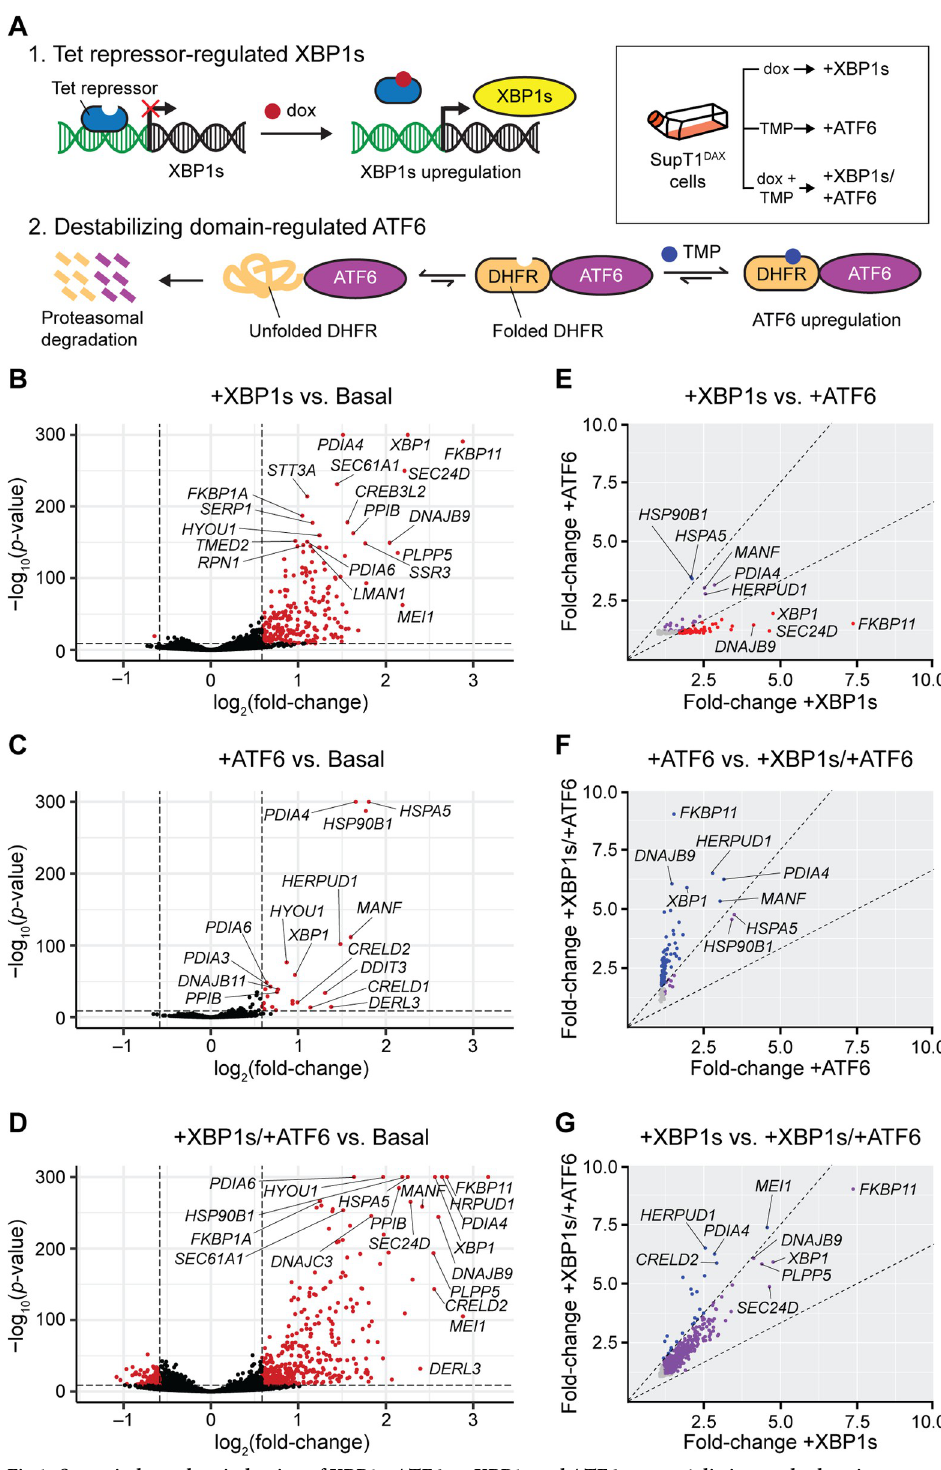
Fig 1. Stress-independent induction of XBP1s, ATF6, or XBP1s and ATF6 creates 4 distinct endoplasmic reticulum proteostasis environments in SupT1 DAX cells (basal, +XBP1s, +ATF6, and +XBP1s/+ATF6). (A) Chemical genetic strategy to orthogonally regulate XBP1s and ATF6 in SupT1 DAX cells. (B–D) RNA sequencing (RNA-Seq) analysis of the transcriptomic consequences of (B) XBP1s, (C) ATF6, and (D) XBP1s/ATF6 induction. Transcripts that were differentially expressed under each condition based on a > 1.5-fold change in expression level